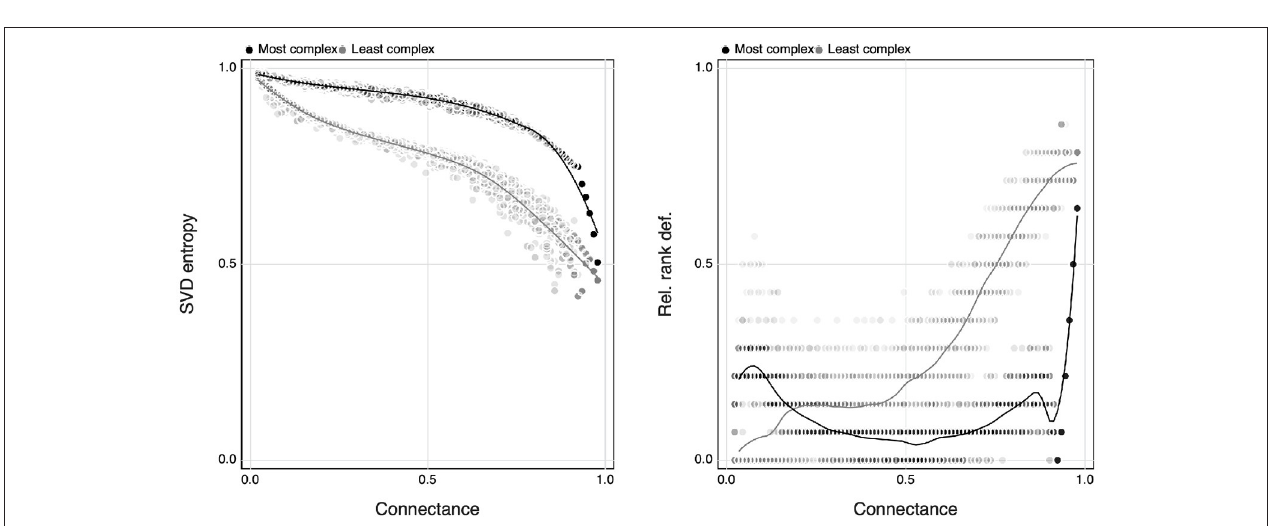
FIGURE 6 | The relationship between the maximum and minimum value of SVD entropy of a collection of random interaction networks (using simulated annealing) for a given connectance spanning from 0 to 1 (left) and how this relates to the relative rank deficiency of networks (right) .